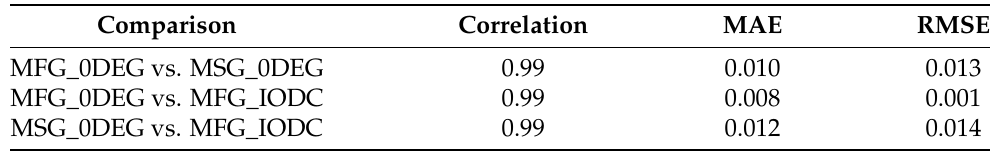
Table 5. DHR30 correlation, MAE and RMSE among Meteosat satellites located at 0 ◦ (MFG_